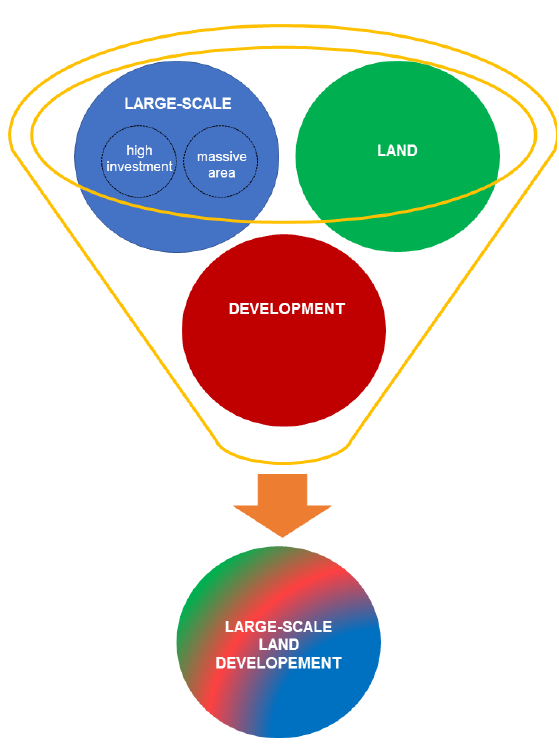
Figure 1. Large-scale land